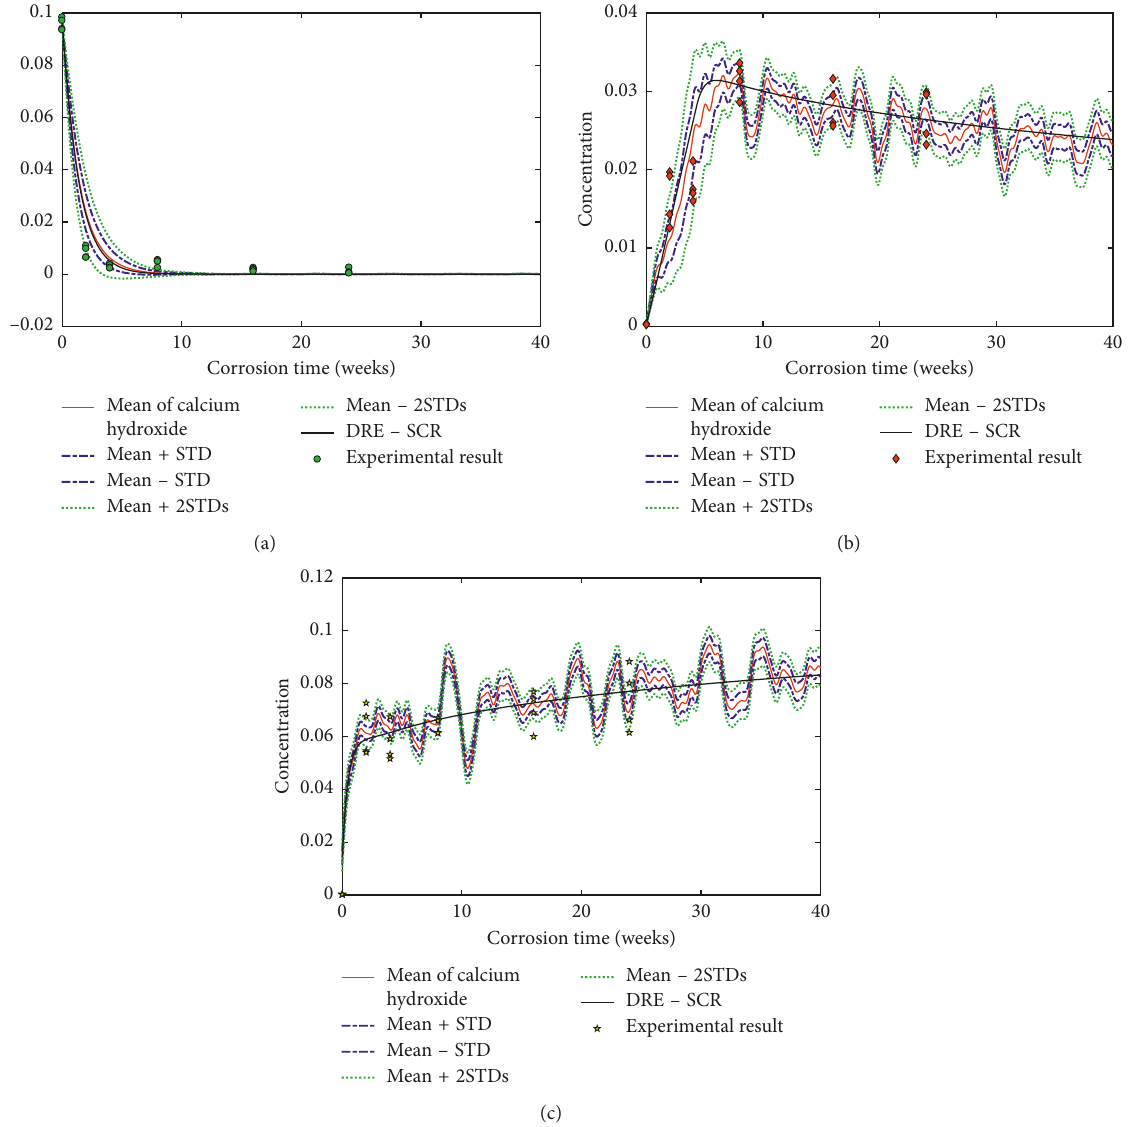
Figure 8: Comparison of the experimental data and the predictions of the SKE-SCR for (a) calcium hydroxide, (b) gypsum, and (c)